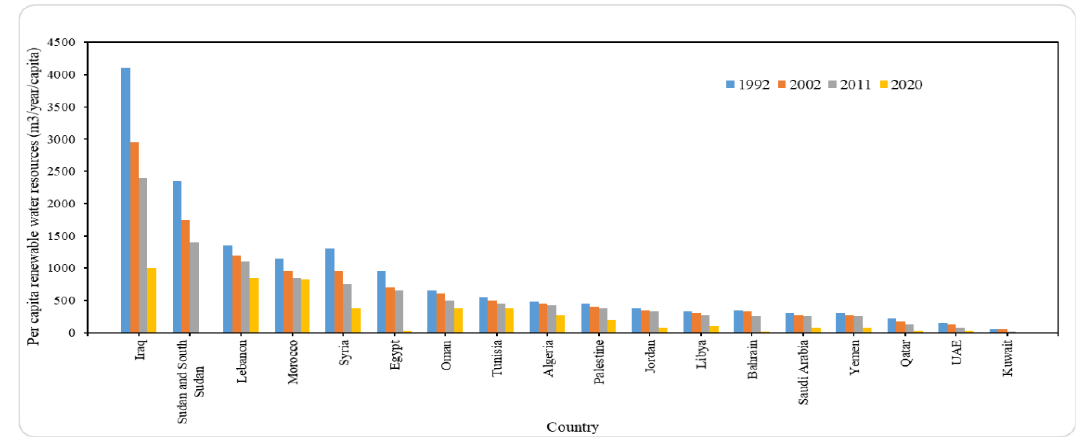
Figure 5. Per capita renewable water resources in the MENA region for the years 1992, 2002, 2011, and 2020 (source: [89,90]).